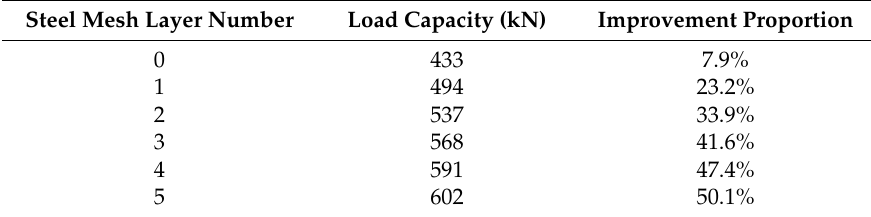
Figure 17. Effect of layer number of steel mesh. Table 4. Improvement proportion caused by increasing layer number of steel mesh.